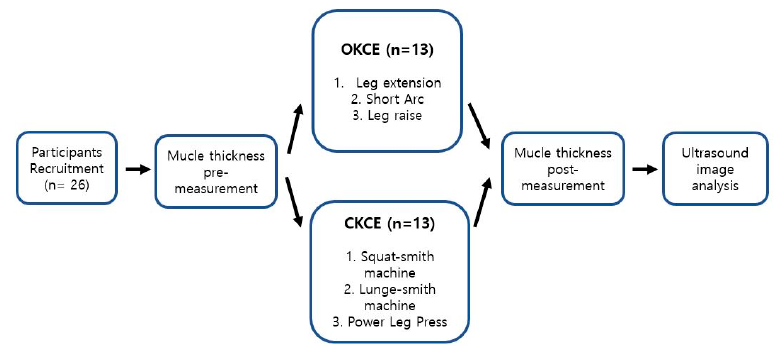
Figure1. Overviewofthestudydesign, Figure 1. Overview of the study design, demonstrating the muscle thickness pre- and post- measurement.